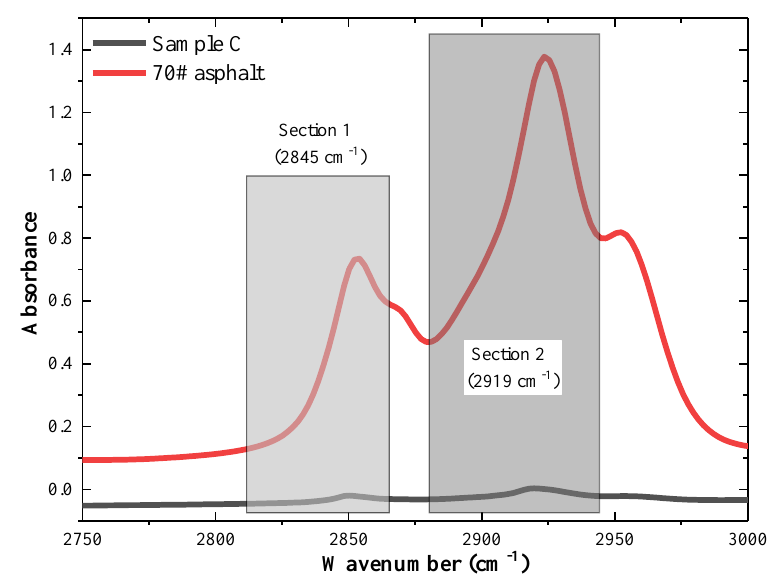
Figure 4. Selected sections for calculating peak areas. Table 5. Peak areas for selected wavenumbers.